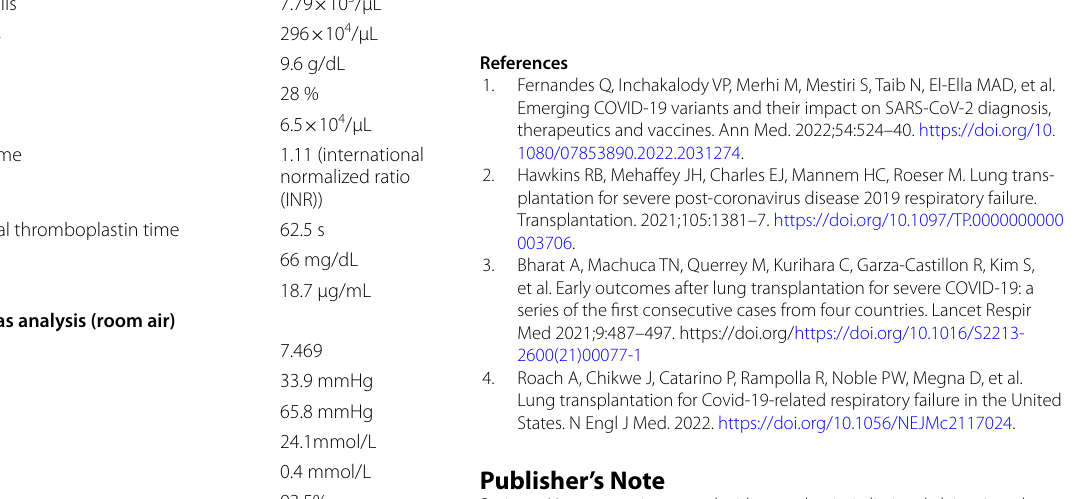
Table 1 Blood examination on transfer to our institution Blood count and coagulation test